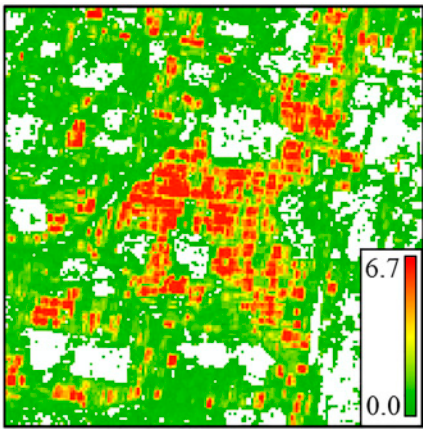
Figure 6. Plastic greenhouse mapping by the plastic greenhouse film index (PGI)-based model in a sample area in Weifang City, Shandong Province, China [72].